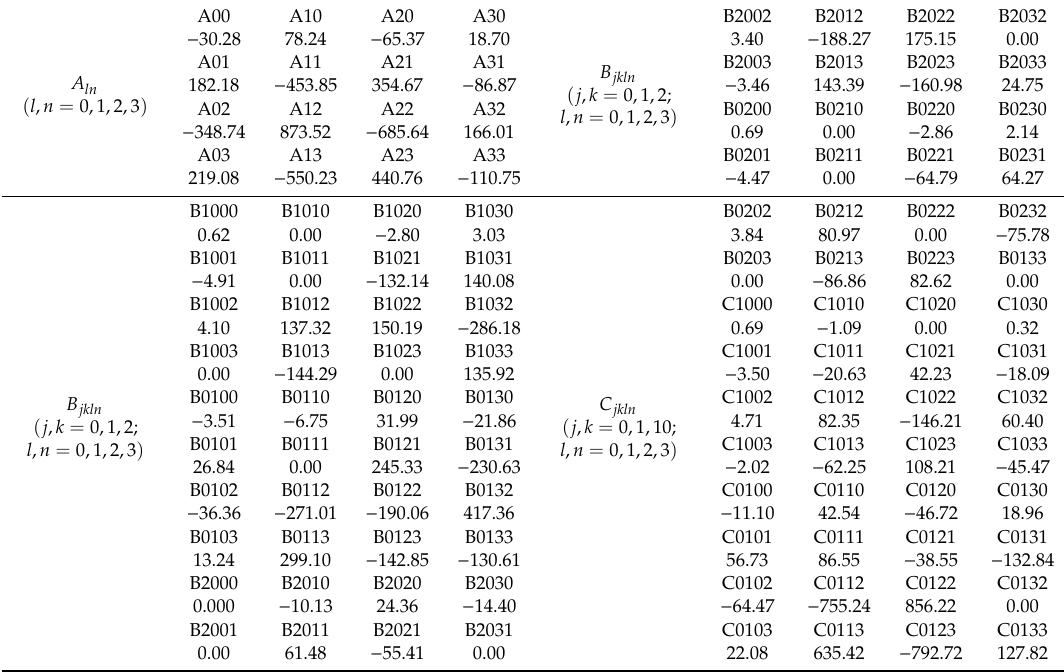
Table 11. Coe ffi cients of spatiotemporal hybrid model of typical measuring points ( a 0 = − 1.04)